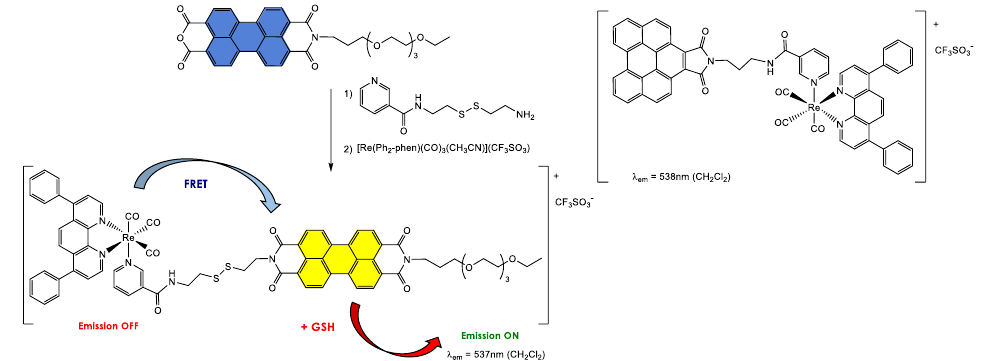
Figure 3. Synthesis of the amphiphilic and zwitterionic PDI derivative; illustration of self-assembly and disassembly of vesicles into cell membrane and imaging of HeLa cells. Reprinted with permission from reference [98]. Copyright 2017 American Chemical Society.